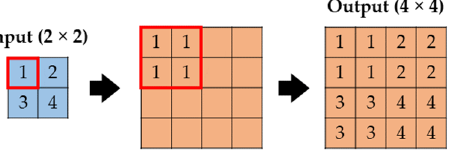
Figure 12. Up-sampling by nearest-neighbour interpolation.